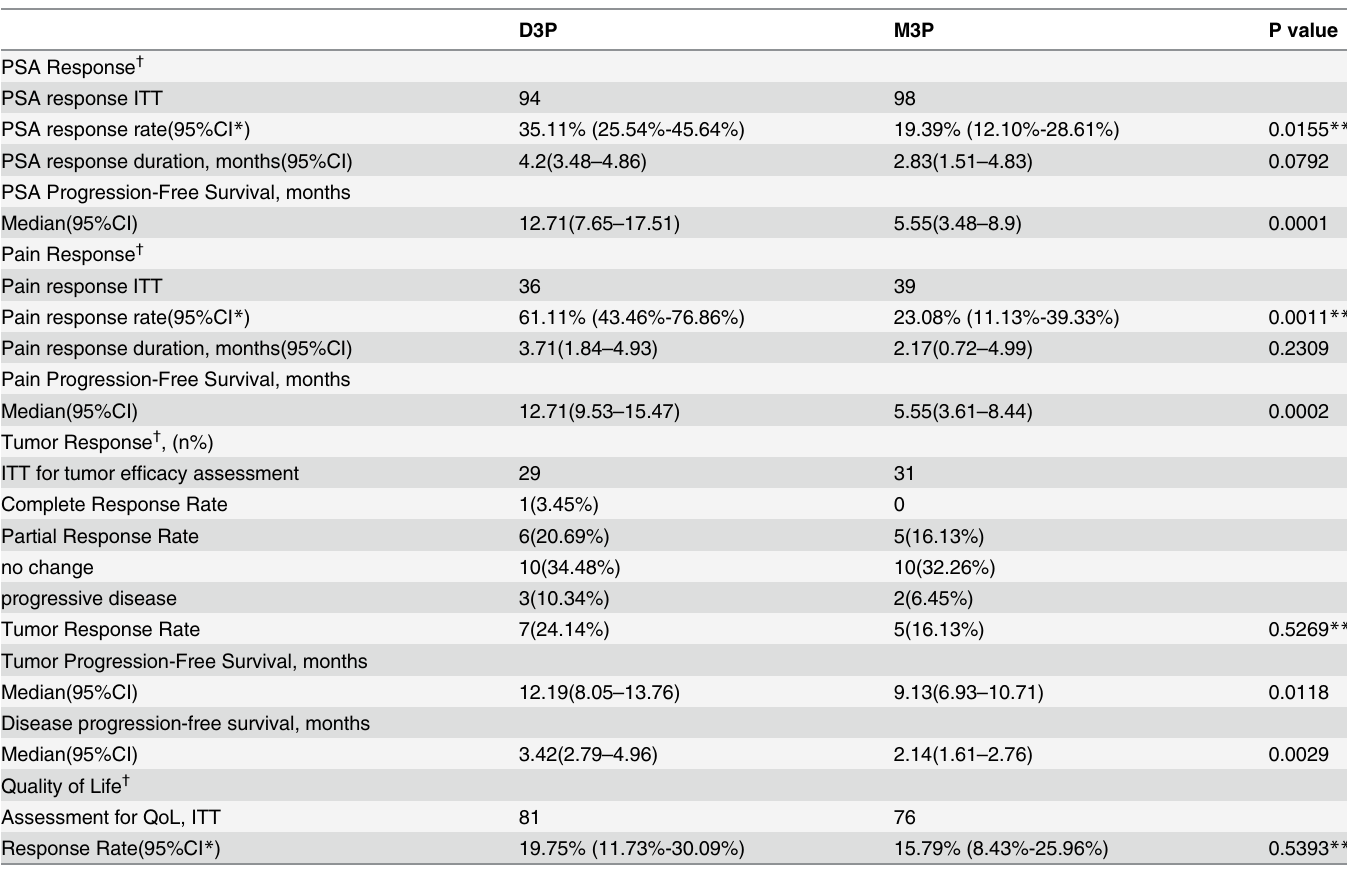
Table 3. Results of secondary outcome.